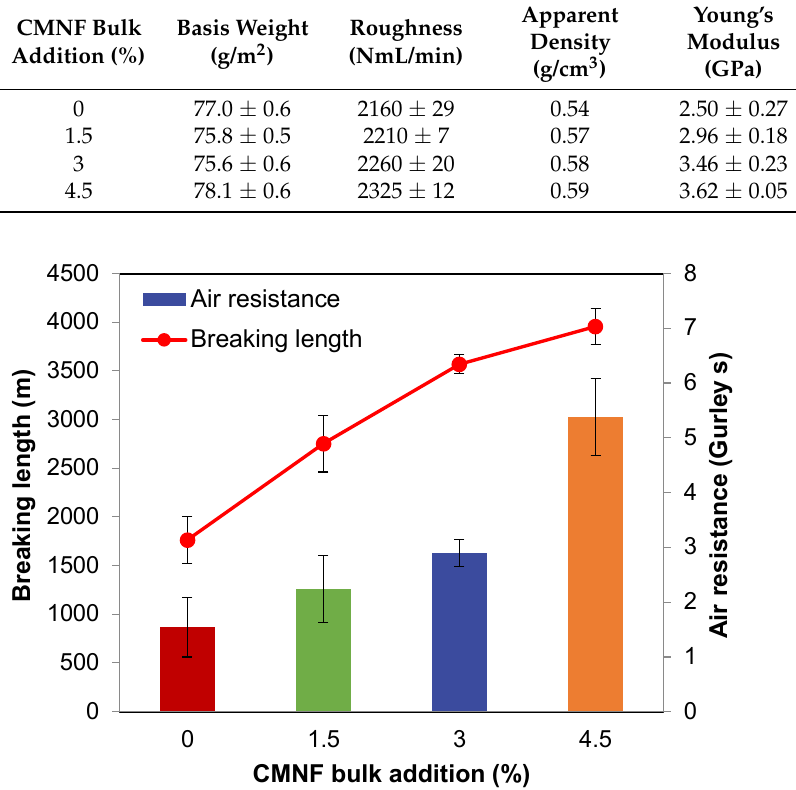
Figure 3. Evolution of breaking length (line) and air resistance (columns) with the proportion of micro-/nanofibers in bulk. Error bars correspond to twice the standard deviation.